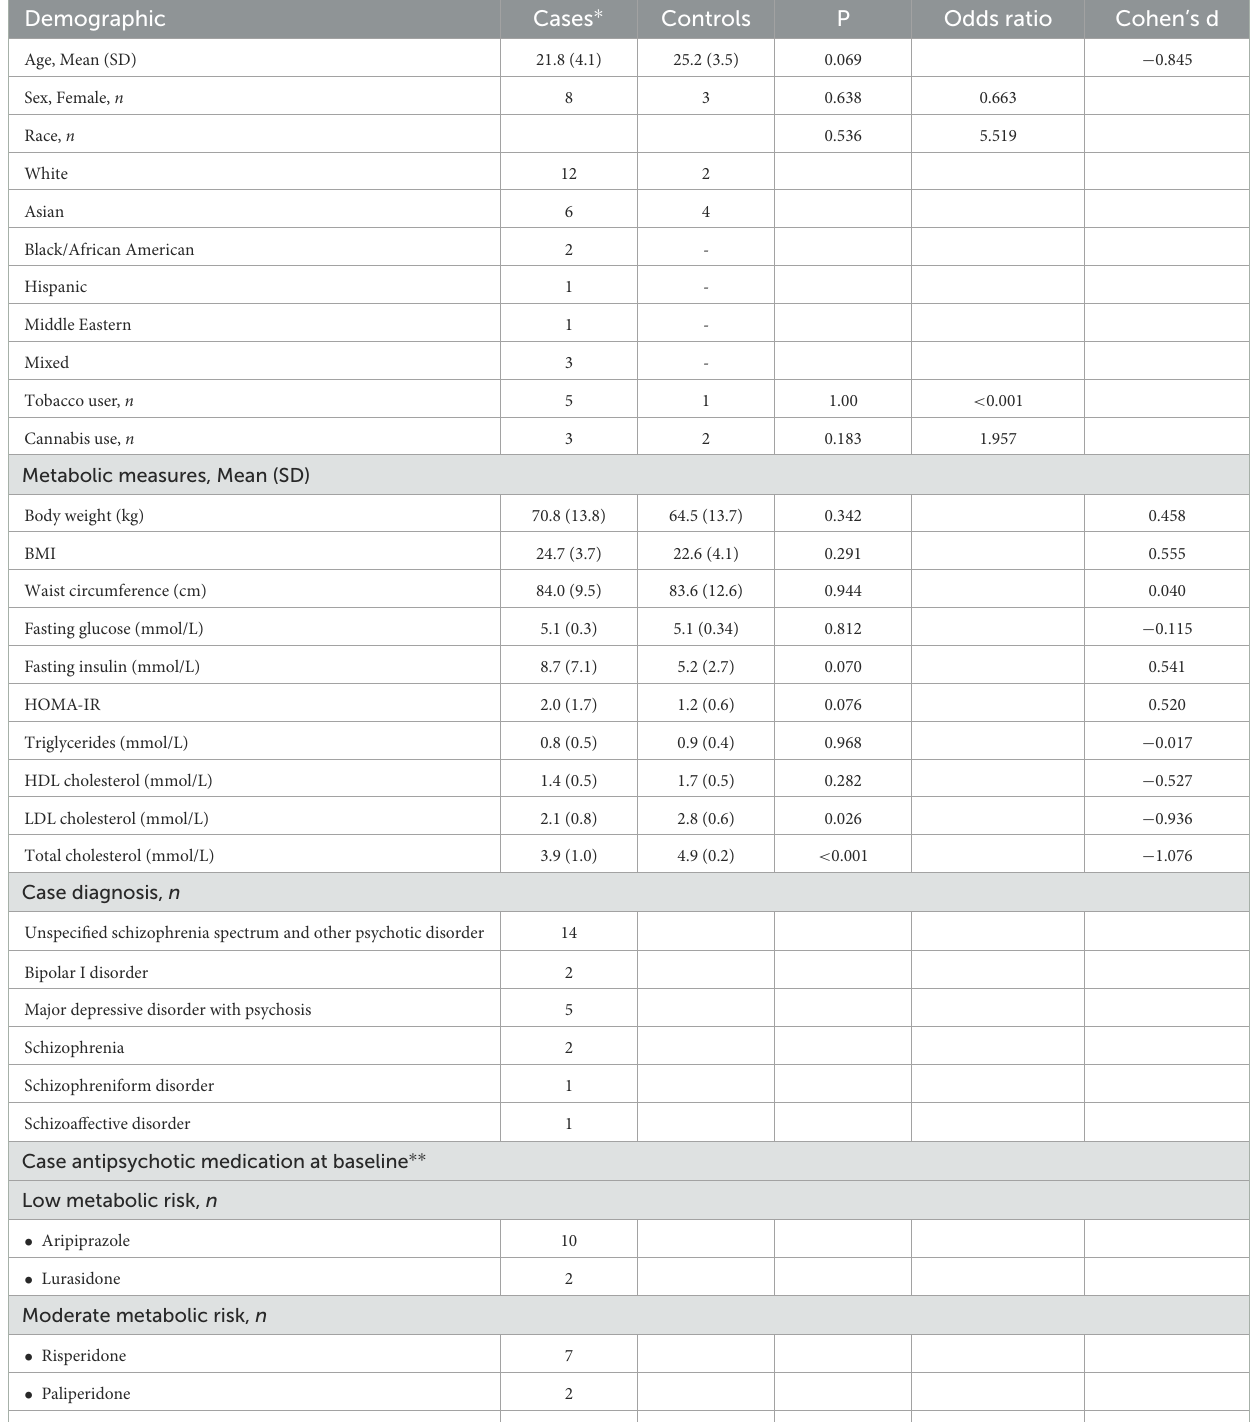
TABLE 1 Baseline demographics of cases ( N = 25) and controls ( N = 6).